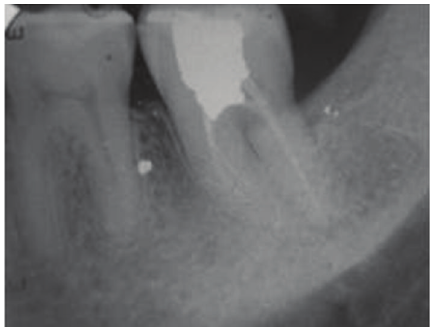
Figure 4: 1-year recall